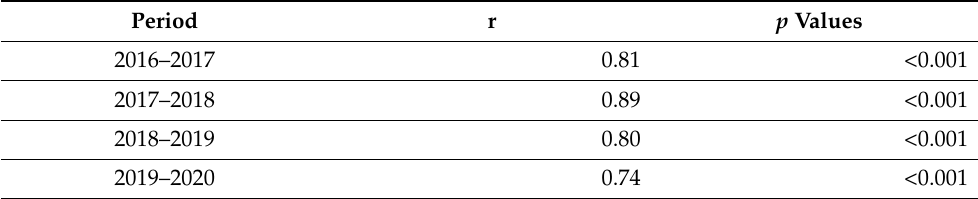
HSHR = hospital standardized home-transition ratio. r = correlation coefficient (Spearman’s non-parametric correlation). p values = two-sided significance.